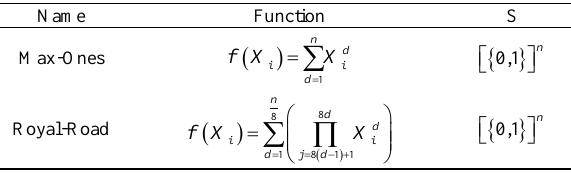
Table 1. Binary benchmark functions.